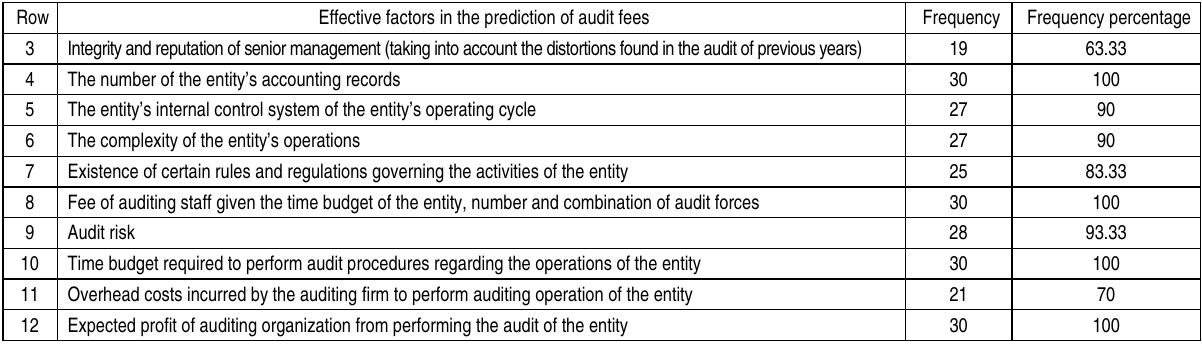
Table 3 (cont.). Factors influencing the prediction of audit fees